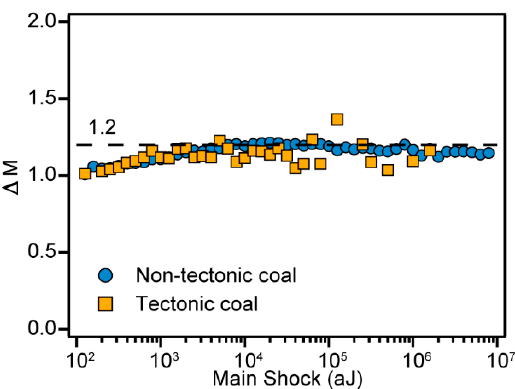
Figure 7. Relative magnitude < ∆ M > versus mainshock energy for non-tectonic and tectonic coal. Dashed horizontal line (1.2) indicates the prediction of Båth’s law.